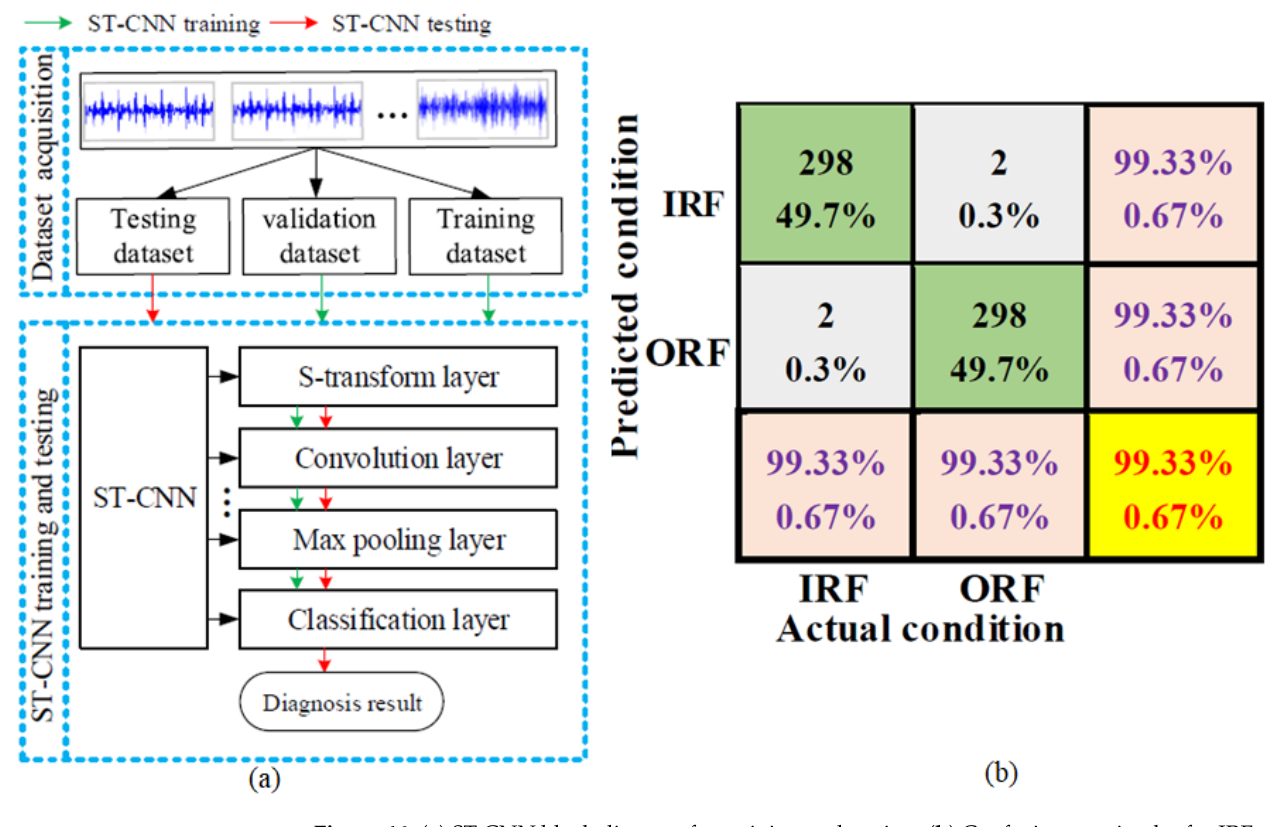
Figure 46. ( a ) ST-CNN block diagram for training and testing. ( b ) Confusion matrix plot for IRF and ORF [120].